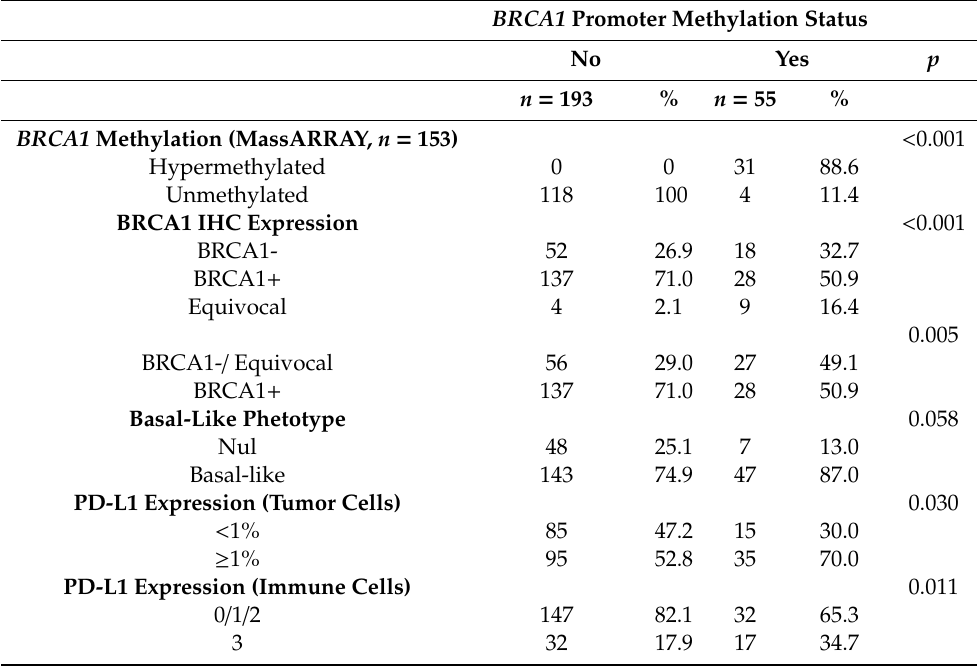
Table 2. Univariate clinicopathological correlations with BRCA1 promoter methylation using MS-PCR.